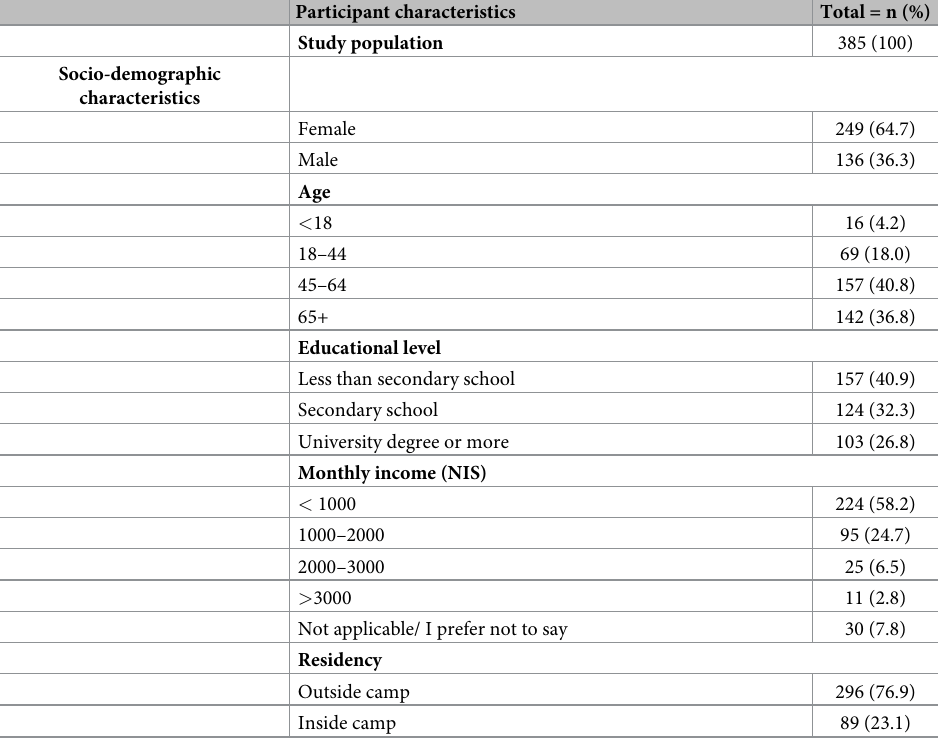
Table 1. Overview of participant